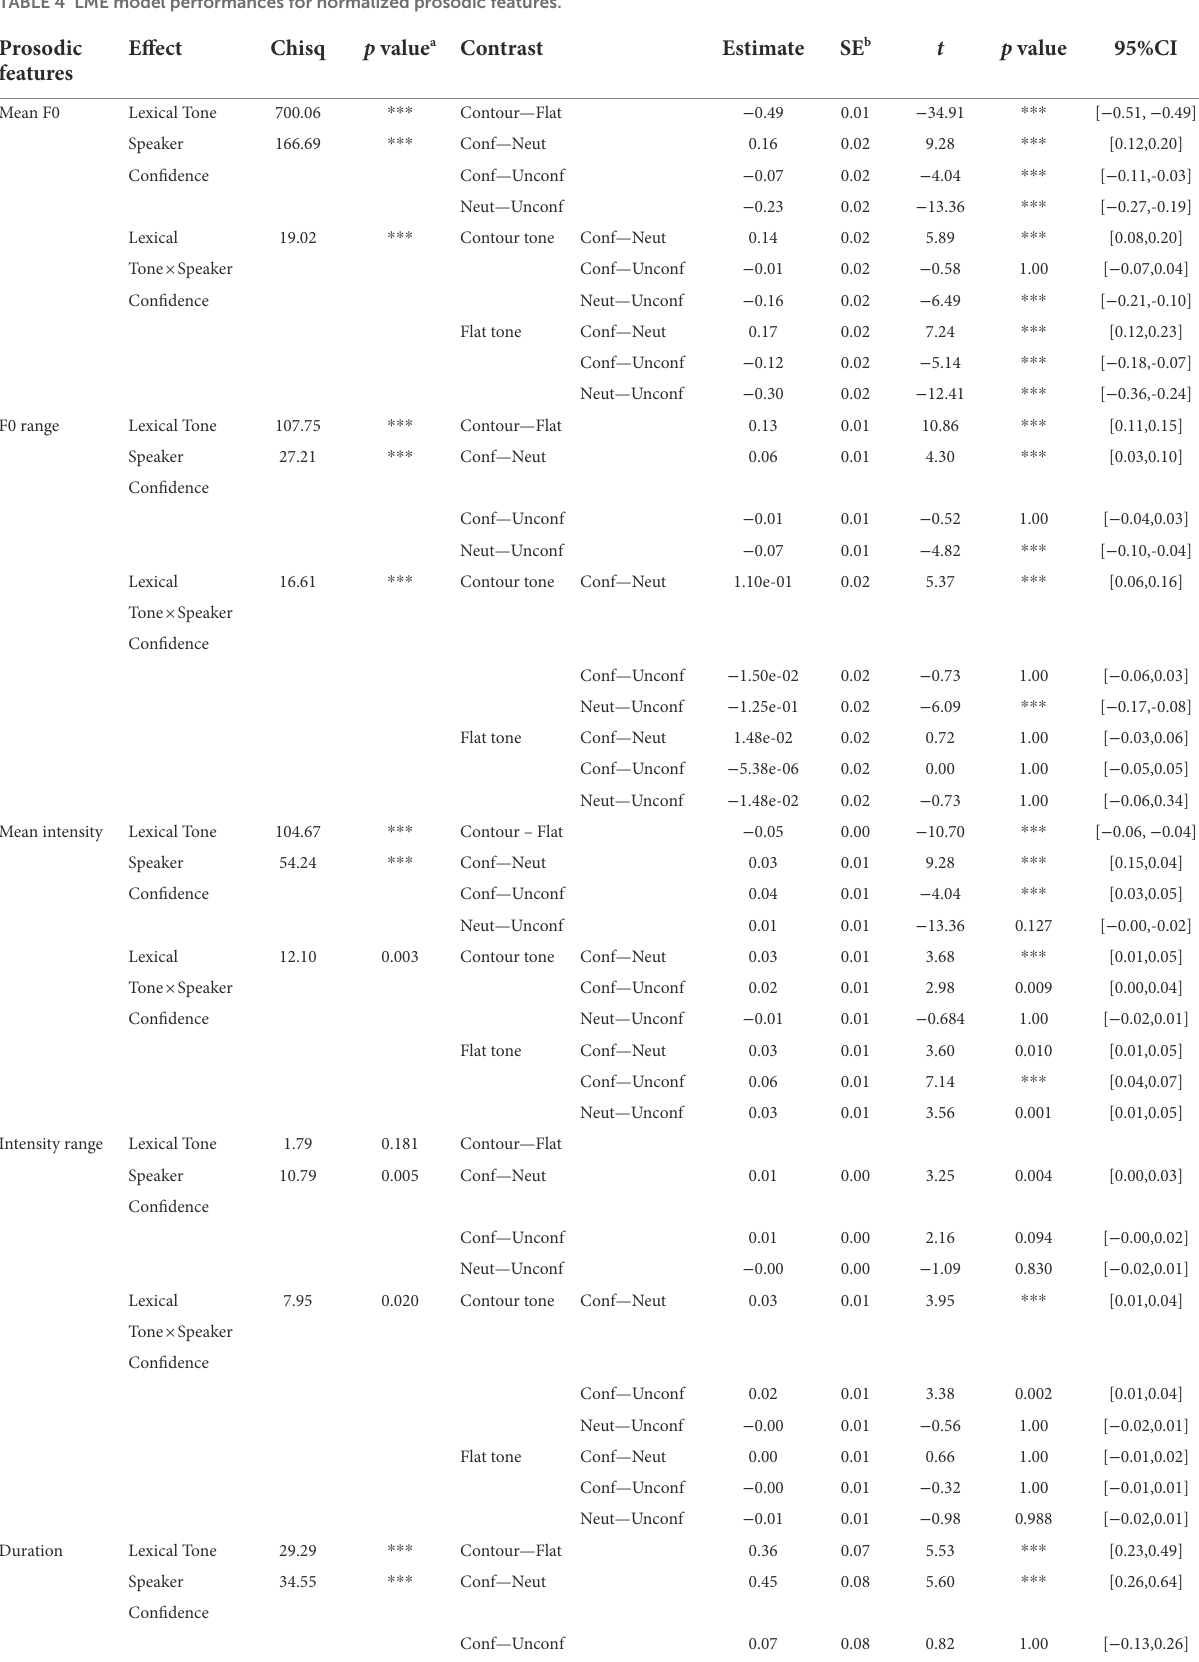
TABLE 4 LME model performances for normalized prosodic features. Prosodic